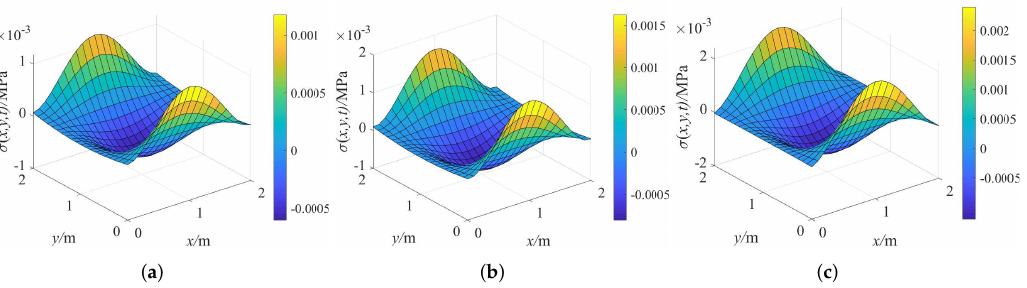
Figure 6. Stress of the plate under external load F = 0.08sin ( 0.01 t ) at different plate thickness for ( a ) h = 0.02m. ( b ) h = 0.04m. ( c ) h =